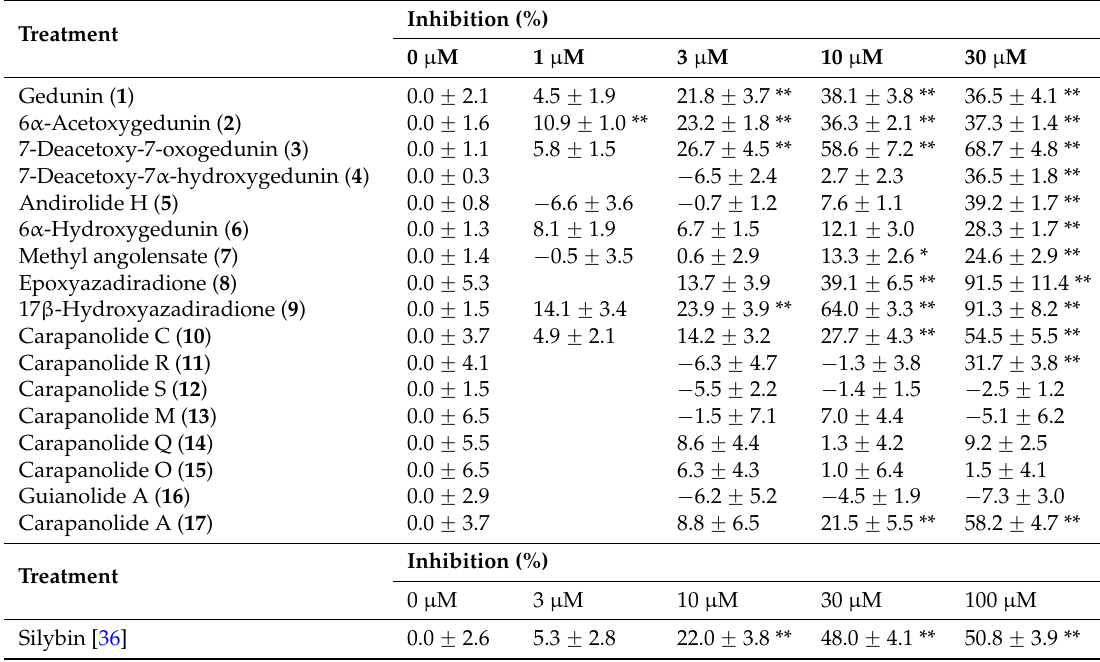
Table 4. Inhibitory effects of limonoids ( 1 – 17 ) on TNF- α -induced cytotoxicity in L929